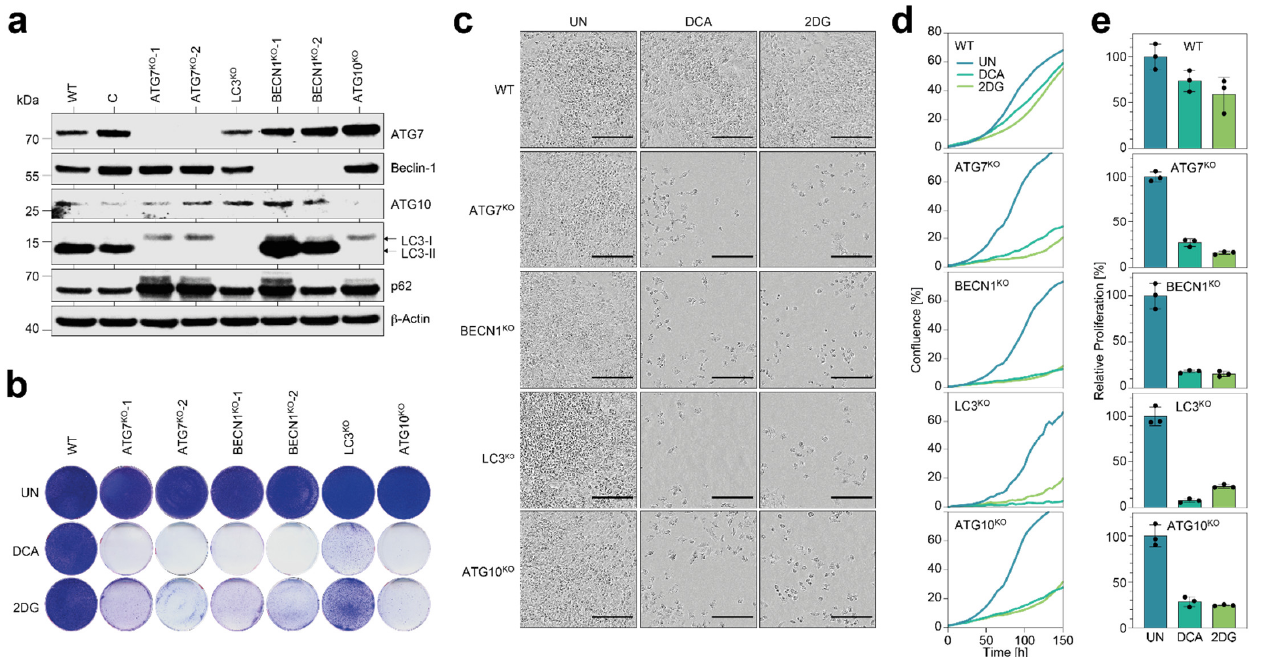
Figure 2. Knockout of BECN1 , LC3 , ATG10, or ATG7 induces hypersensitivity to 2DG and DCA. ( a ) Western blot of indicated cells for autophagy genes. β-Actin is shown as loading control. C, control clone transfected with nontargeting nuclease and WT, wild-type H460. ( b ) Clonogenic growth assay. ( c – e ) Real-time live cell imaging of cells under treatment. ( c ) Morphology. Scale bar = 200 µ m. ( d ) Proliferation kinetics. Shown is the mean confluence in % ( n = 3). ( e ) Proliferation. Shown is the area under the curve (AUC) from the curves in ( d ) relative to untreated. Shown is the mean ± SD ( n = 3). UN,